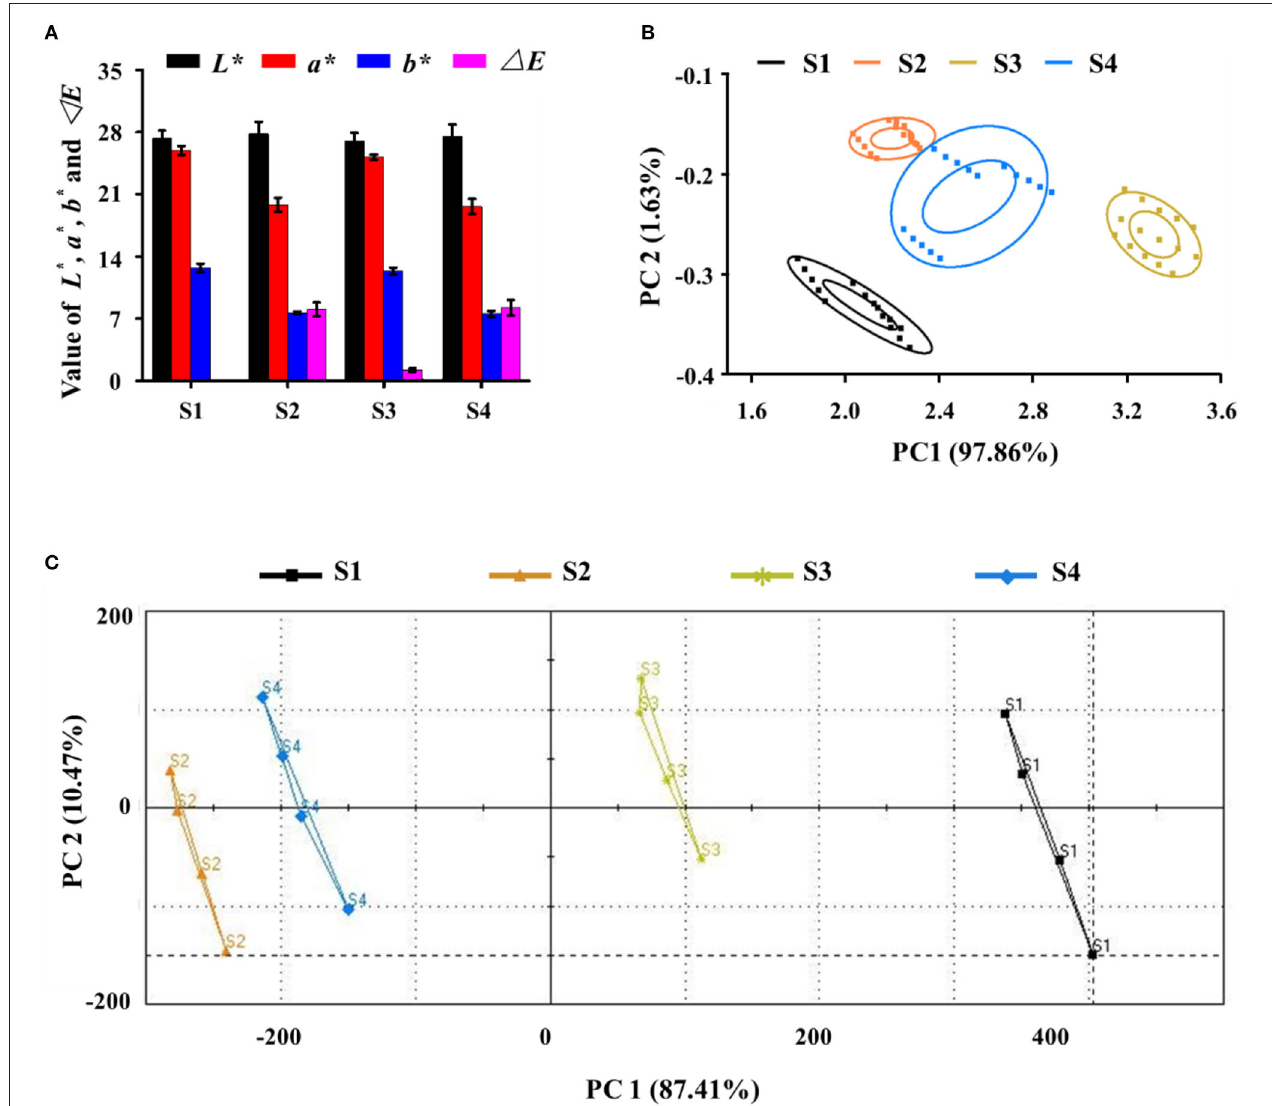
FIGURE 5 | Electronic sensory evaluation of black garlic fermentation broths by (A) the electronic eye, (B) electronic nose (PCA), and (C) electronic tongue (PCA). Data are means ± SD ( n =